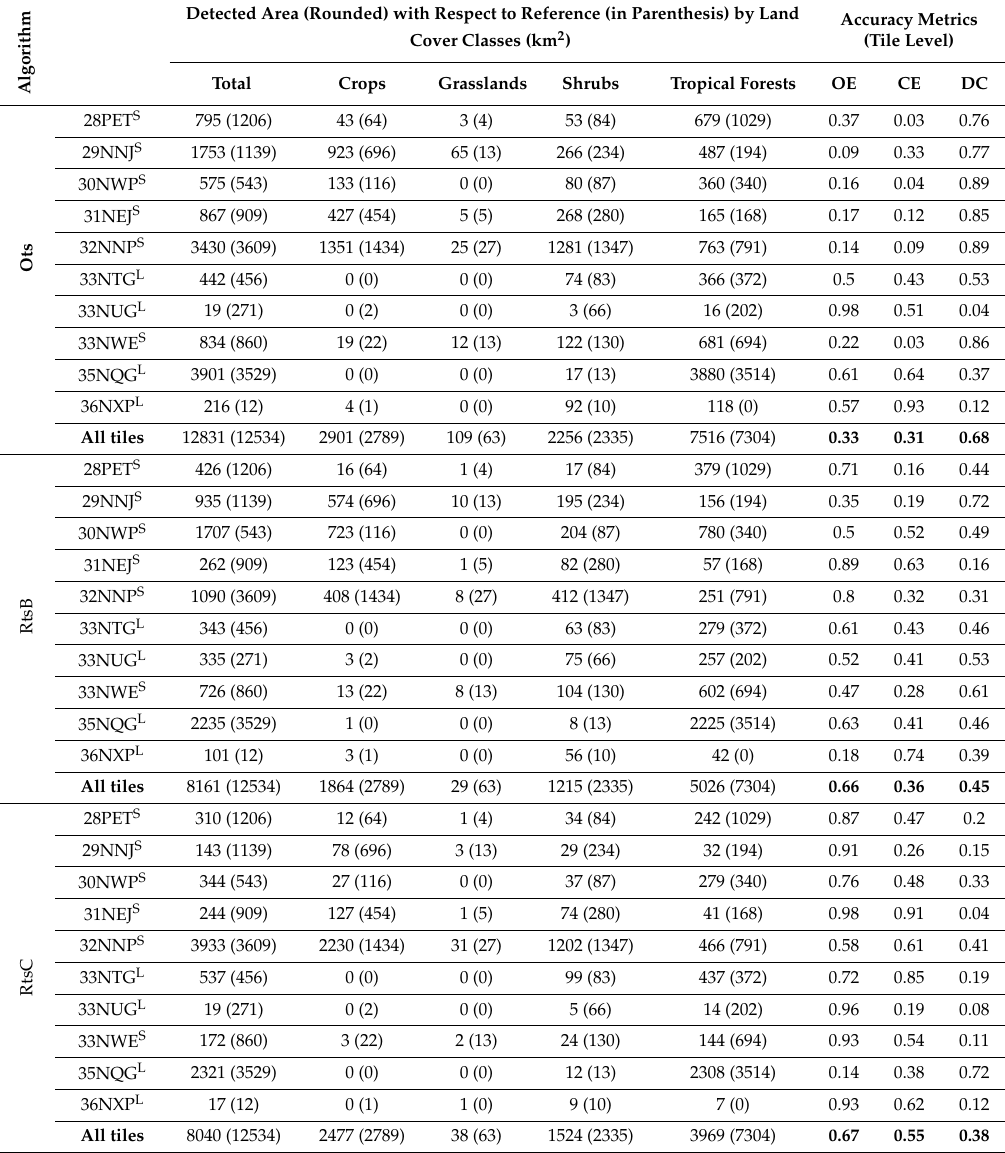
Table 3. Agreement between reference and detected BA by algorithm and tile. L-validation data from Landsat 8 images; S-validation data from Sentinel-2 images. ‘All tiles’ shows values (in bold) computed for a confusion matrix formed by all pixels from the 10 tiles analysed. Detected Area (Rounded) with Respect to Reference (in Parenthesis) by Land Cover Classes (km 2 ) go r A l